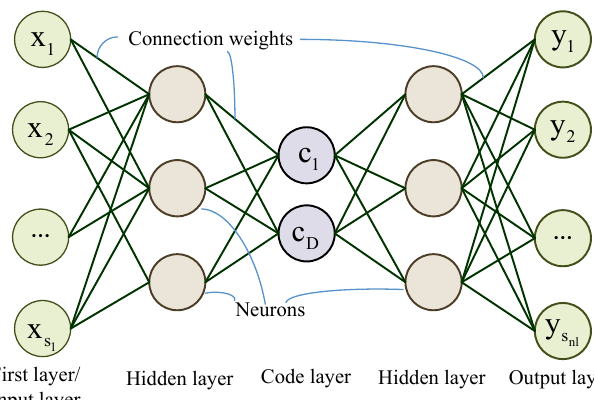
Figure 9. The structure of a common deep learning based HSI